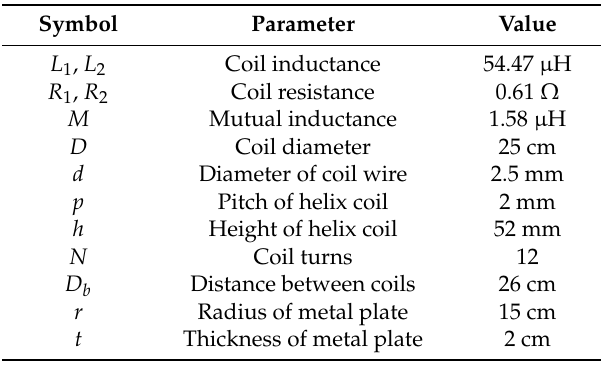
Figure 3. Structure of the helix coils and positions of the metal plate. Table 1. Parameters of helix coils and metal plate.